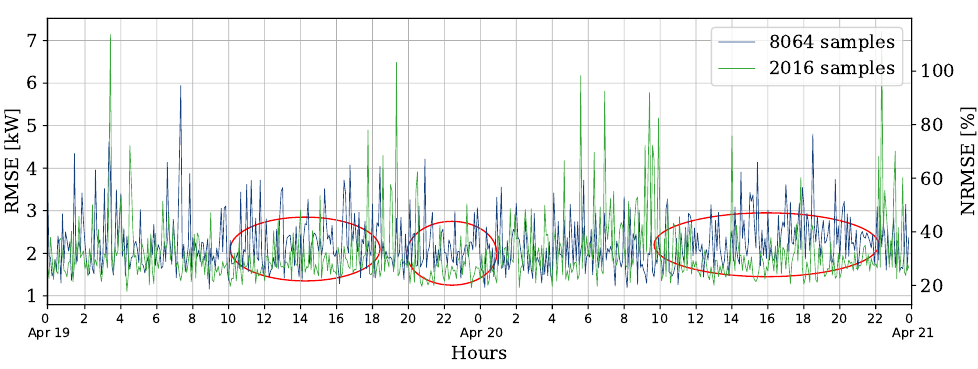
( b ) RMSE for the fixed load model using fixed window sizes